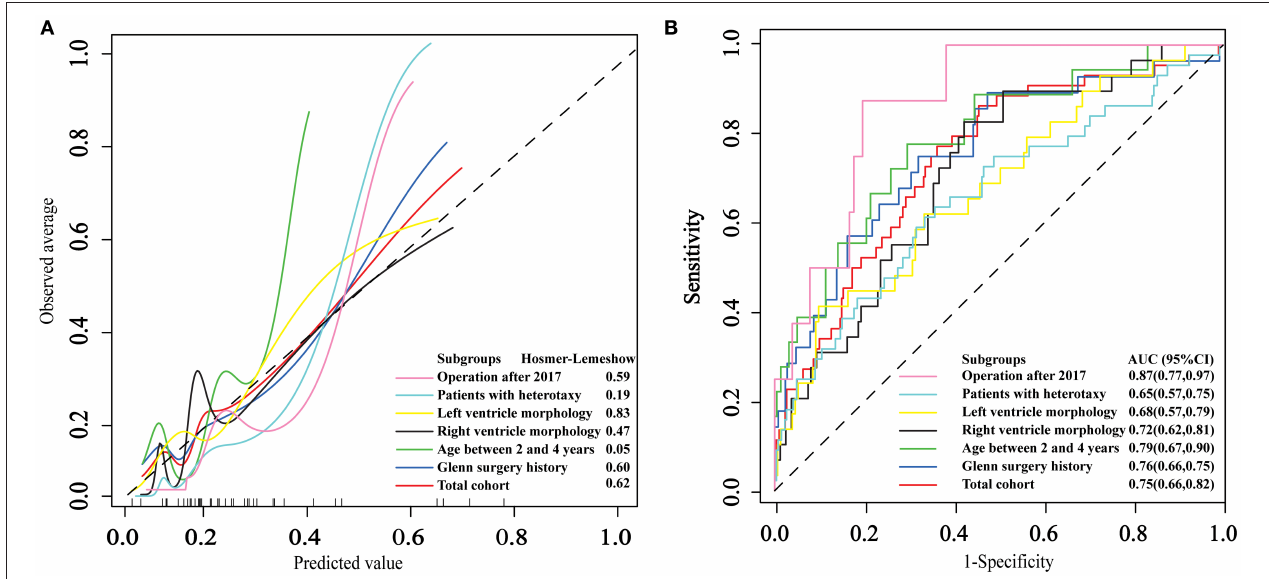
FIGURE 2 | The application and performance of the logistic model in the total cohort and six subgroups. (A) Calibration curves of the logistic model. (B) Receiver operating characteristic curves for persistent acute kidney injury.